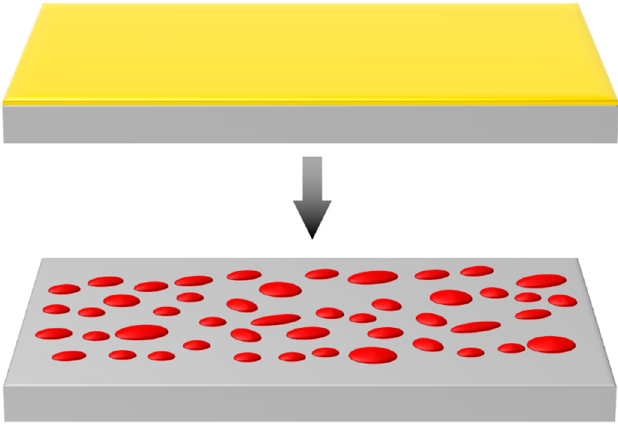
Figure 1. Dewetting of a thin gold film with the formation of nano-islands.